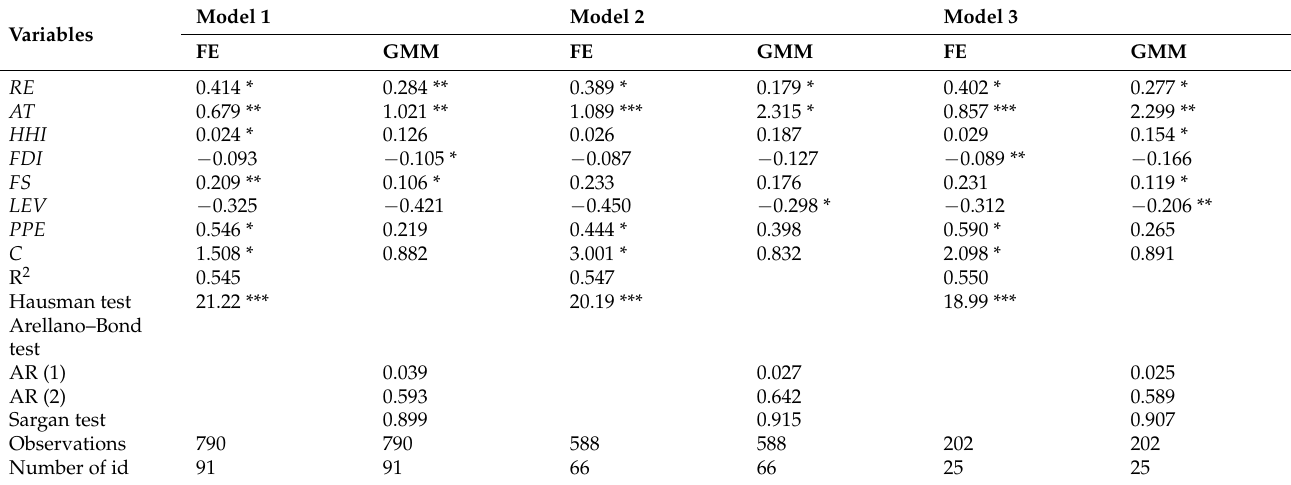
Table 5. Measurement results of the relationship between RE and SG